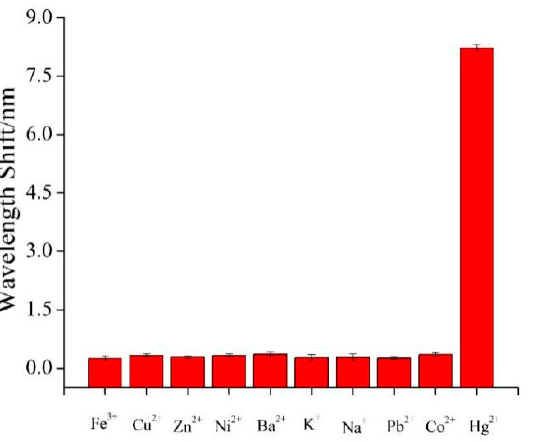
Figure 10. SPR responses for different metal ions based on sandwich structure.